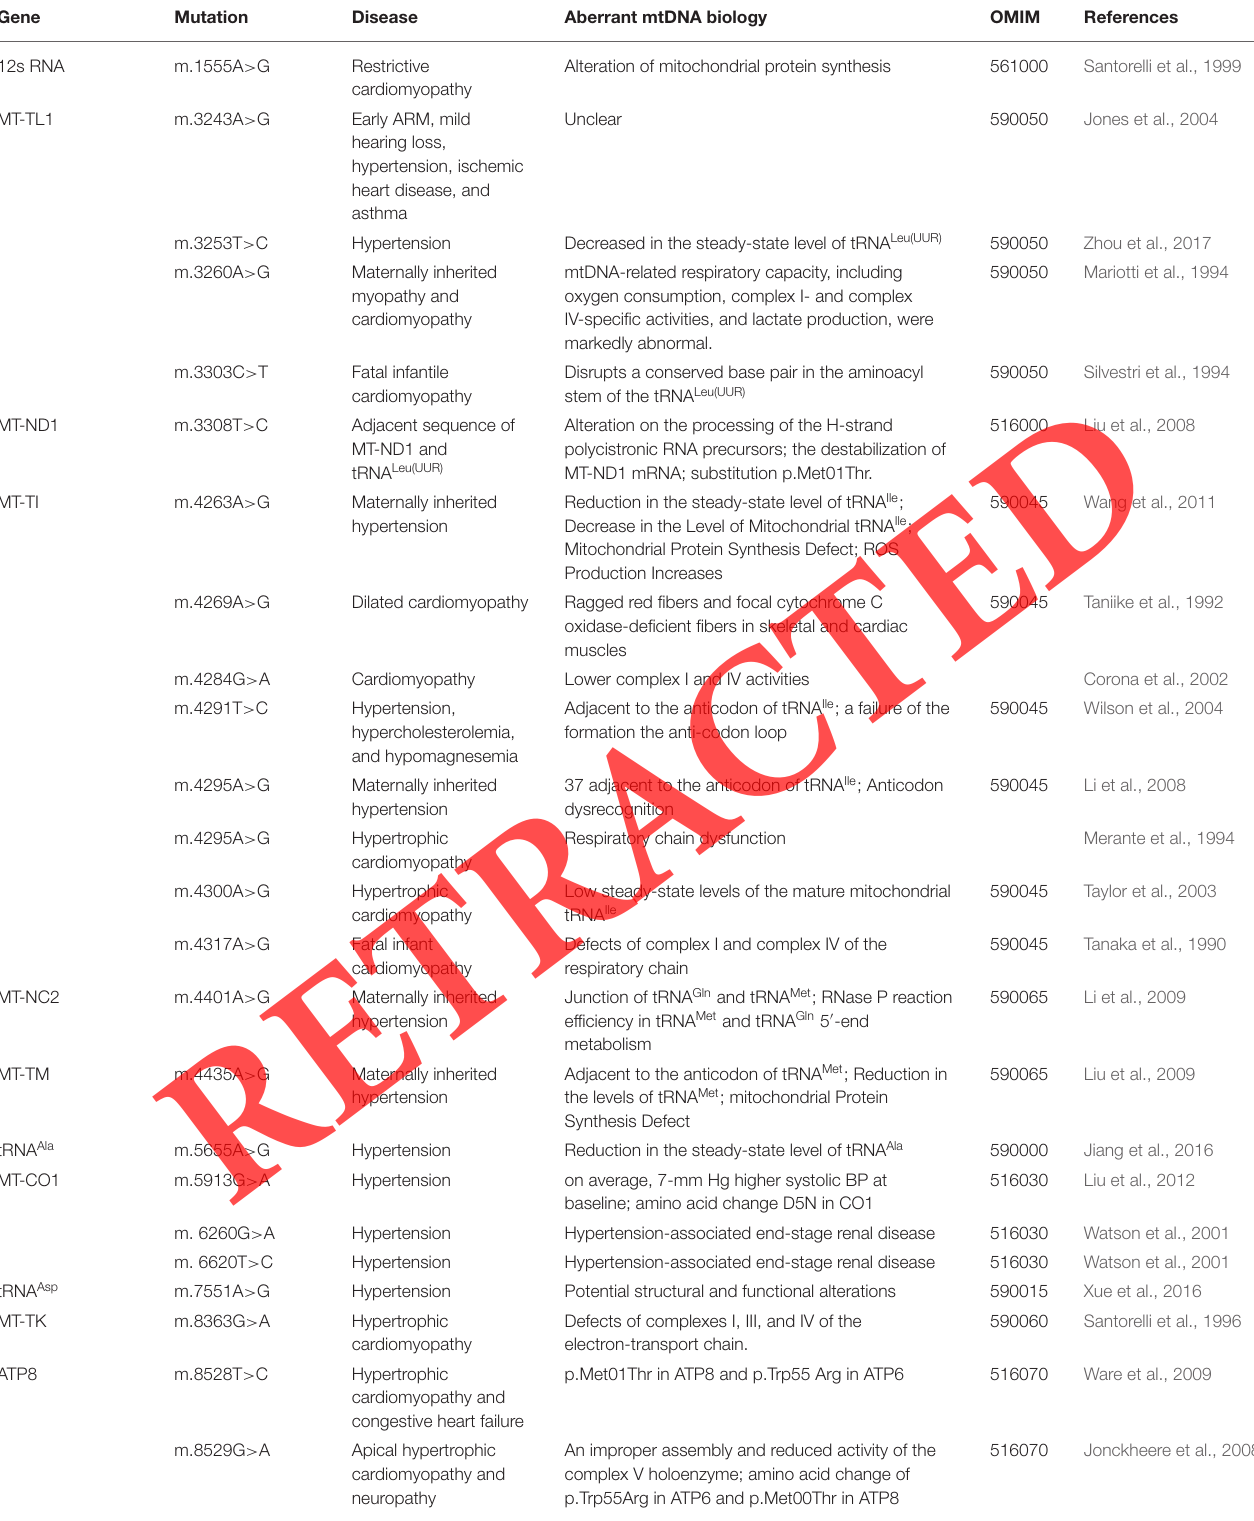
TABLE 1 | MtDNA mutation associated with